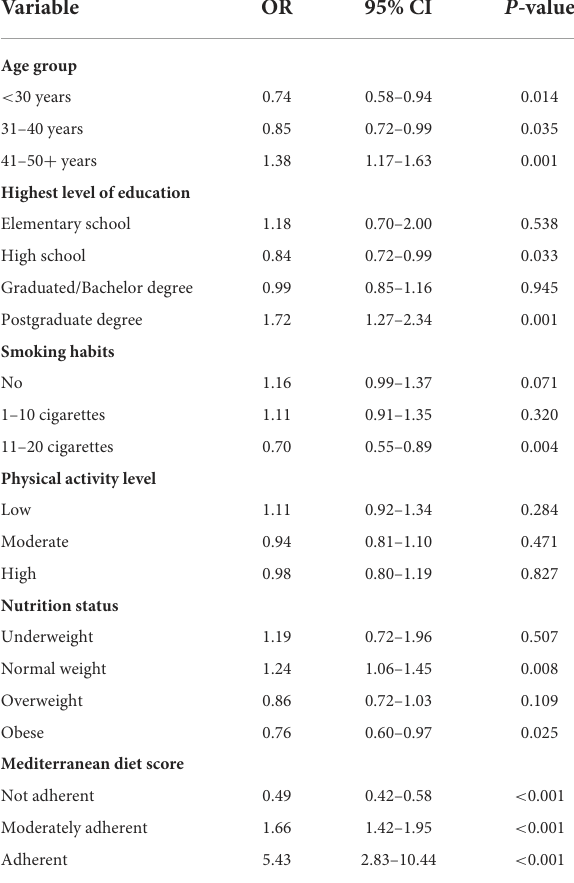
TABLE 2 The association of participants’ socio-demographic characteristics and lifestyle habits with recommended fish